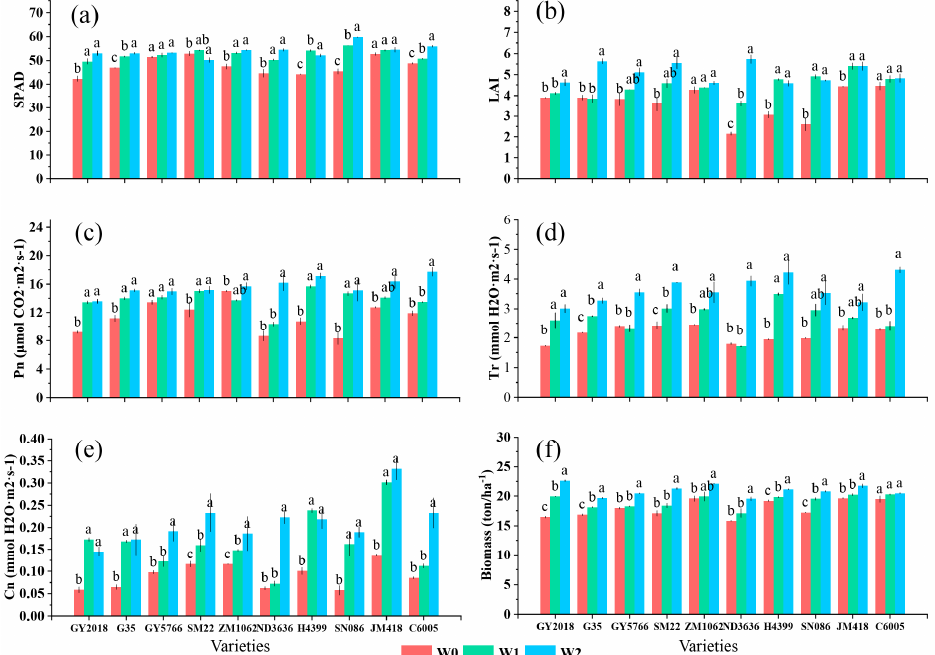
Figure 4. Physiological performances between W0, W1 and W2 treatment based on 20 May and the biomass was at maturity: ( a ) SPAD, ( b ) LAI, ( c ) net photosynthetic rate, ( d ) transpiration rate and ( e ) stomatal conductance, ( f ) Biomass. Duncan’s multiple range test was used to compare the mean values of physiological traits in different water treatments. The means followed by different letters are significantly different at p < 0.05. Table 3. The yield of different varieties under different deficit irrigation systems.